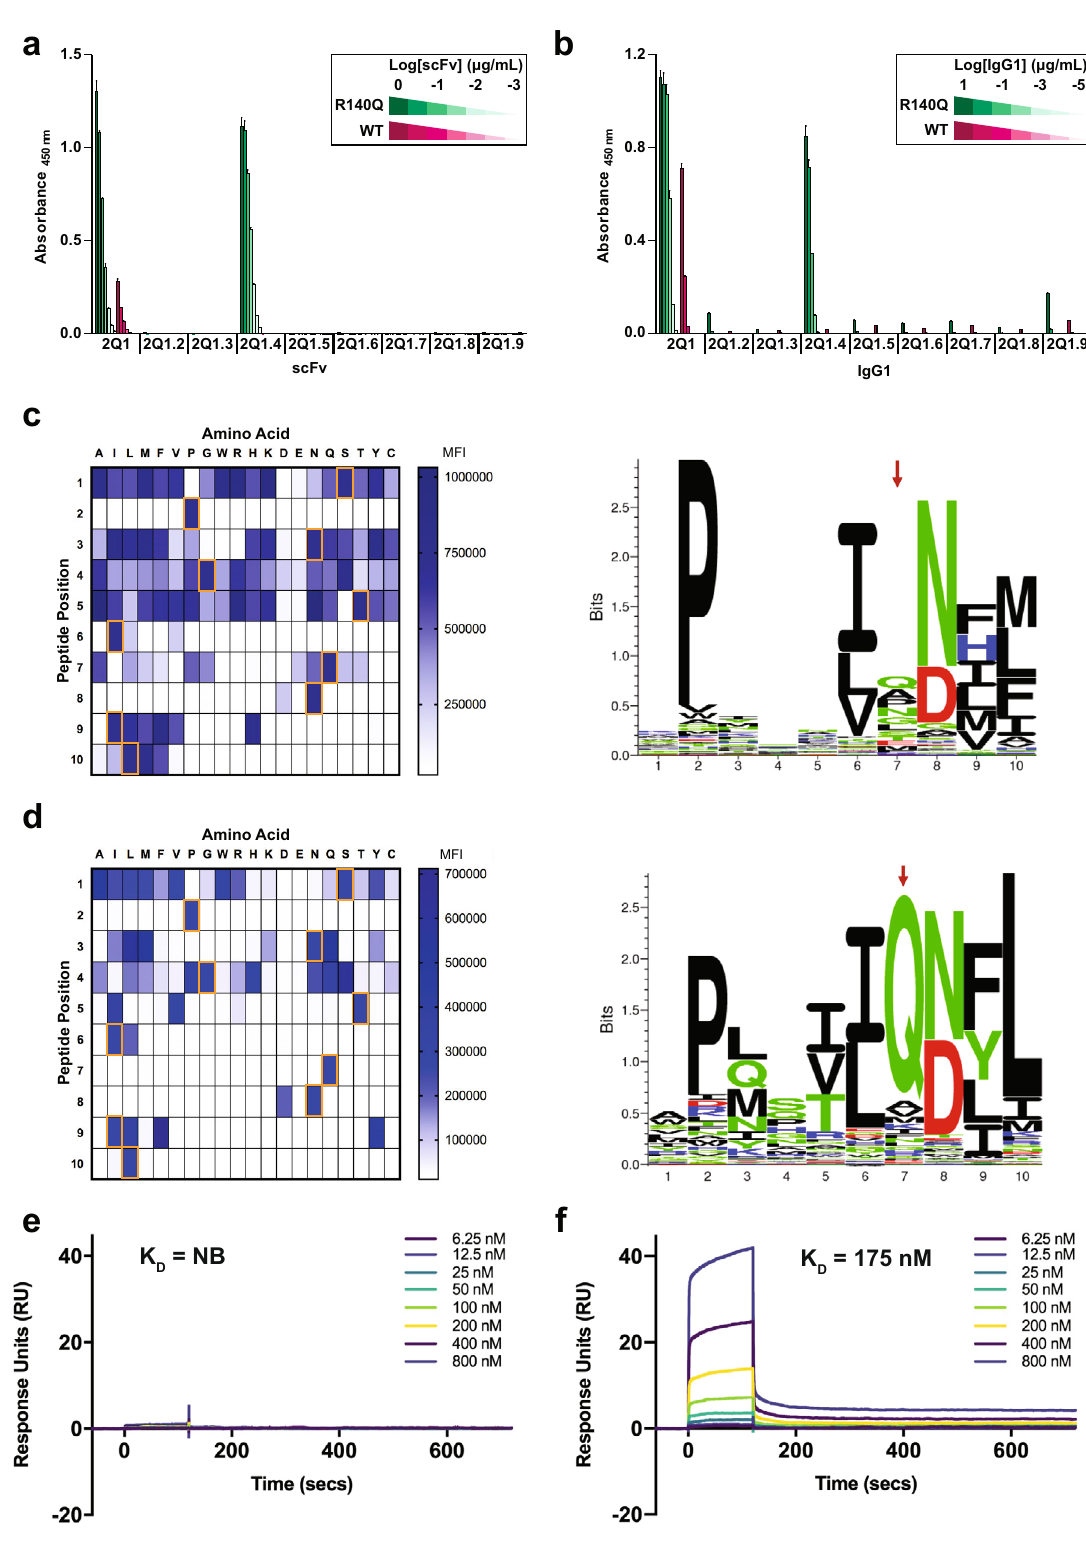
of its speci fi city. A subtle difference in backbone fl exibility and conformation due to the length and interactions of the buried residue allows for the selectivity of the 2Q1-Fab. This is in con- trast to known buried viral escape mutants which result in pep- tide bulging 75 . Importantly, the crystal structure enabled molecular modeling of the TCRm/pHLA interaction which resulted in the identi fi cation of a variant (2Q1.4) with improved